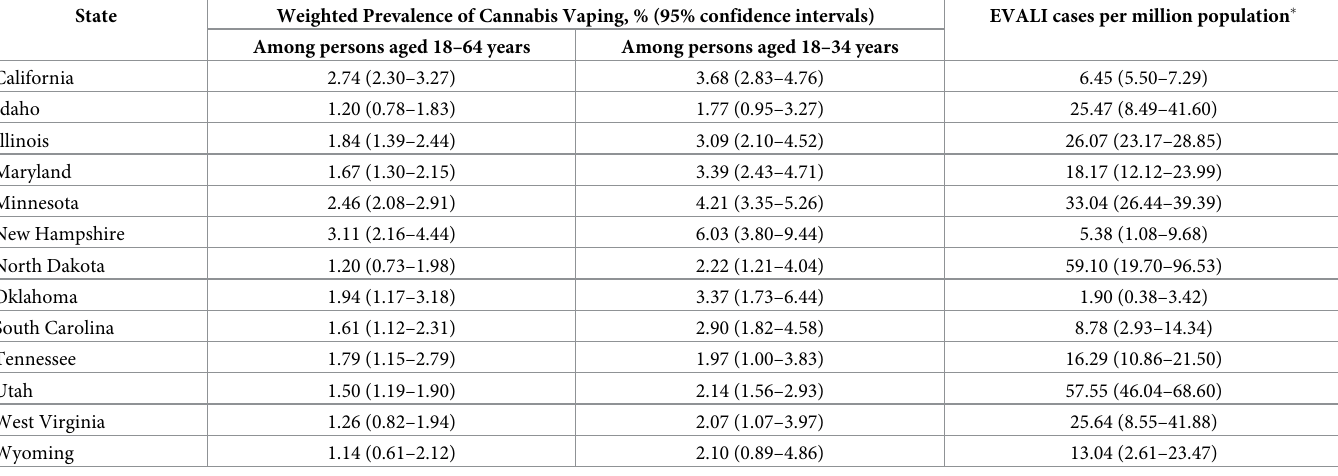
Table 1. Weighted prevalence of cannabis vaping and EVALI cases per million population by state. State Weighted Prevalence of Cannabis Vaping, % (95% confidence